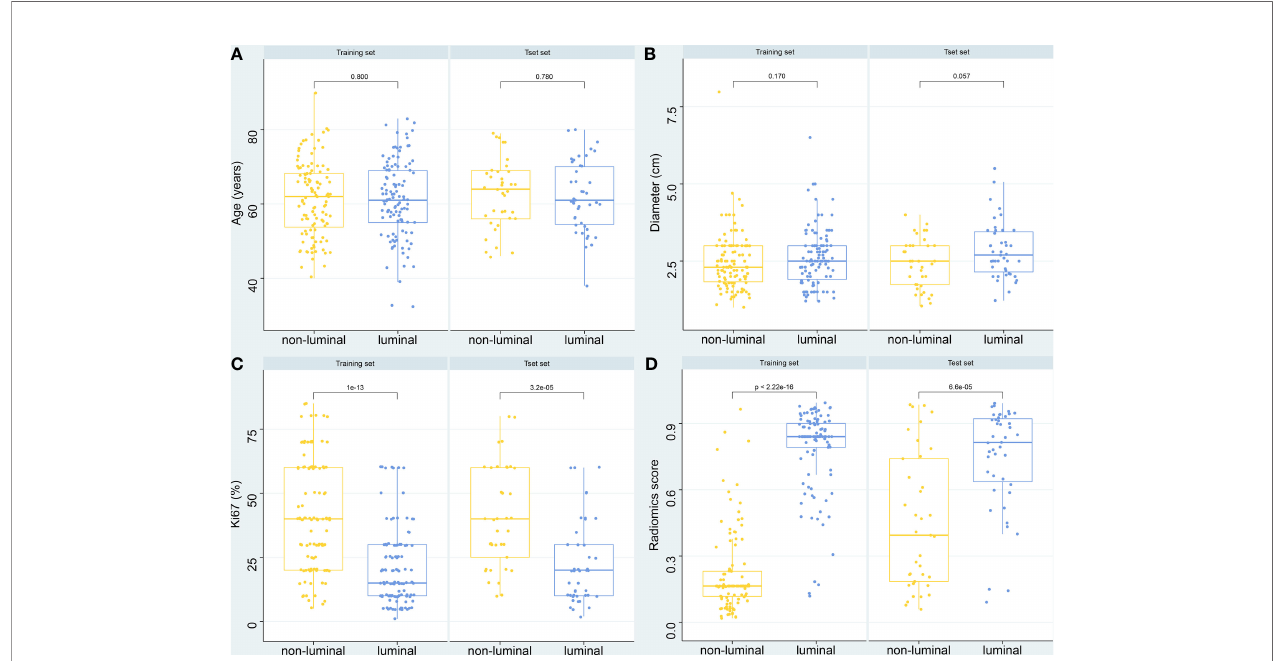
FIGURE 6 | Boxplot of the relationships between different variables and molecular subtypes. (A) Age. (B) Diameters of breast mass. (C) Ki-67 expression level. (D) Radiomics score of the LASSO_SVM